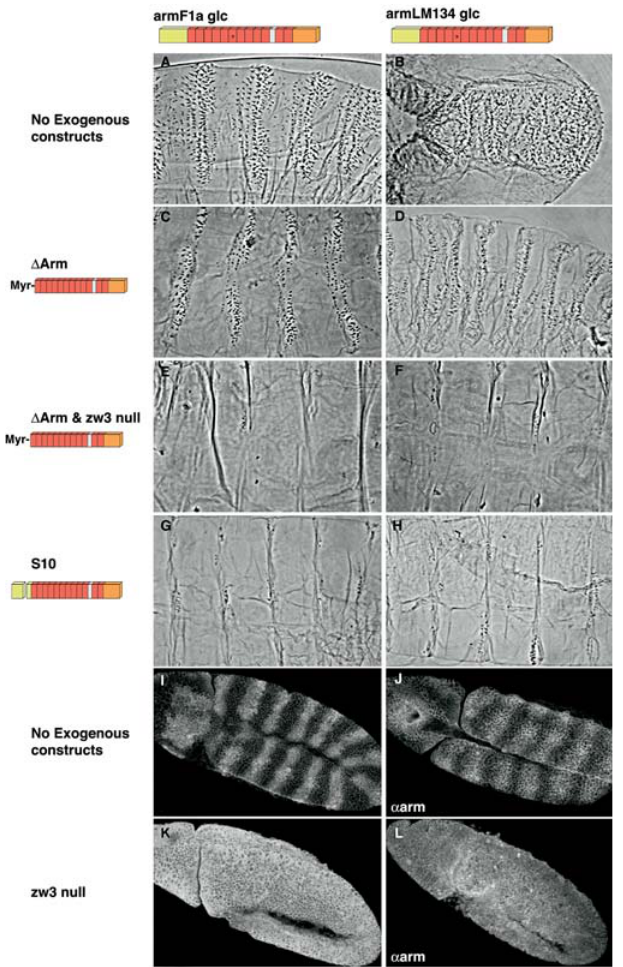
Figure 5. D Arm Functions through Endogenous Arm (A) Embryonic cuticle of arm F1a mutant showing a weak loss-of- function phenotype. (B) Cuticle of arm LM134 mutant embryo showing a strong loss-of- signaling phenotype. (C) Embryo mutant for arm F1a expressing Arm D Arm showing relatively normal segment polarity. (D) arm LM134 mutant expressing Arm D Arm also shows segment polarity. (E and F) Both alleles in combination with a null zw3 allele and expressing Arm D Arm show a complete lack of denticles. (G and H) Both alleles expressing the activated but nontethered form of stabilized Arm, Arm S10 , show the naked cuticle phenotype. (I–L) In both missense alleles, the mutant protein is expressed in stripes (I and J), corresponding with Wg expression (data not shown), which is abolished when the key degradation kinase Zw3 is removed (K and L). DOI: